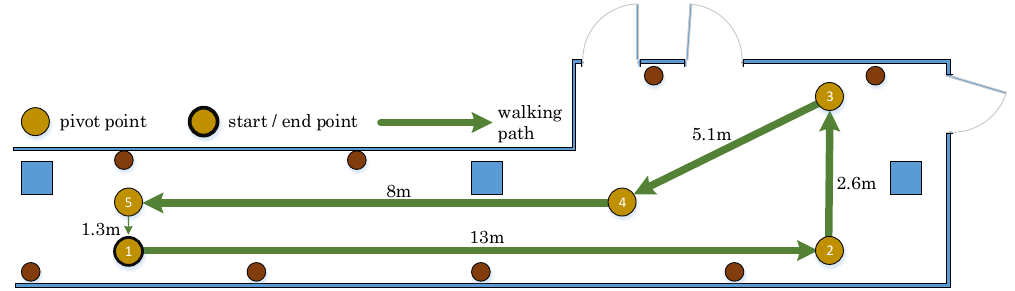
Figure 11. Walking path during the